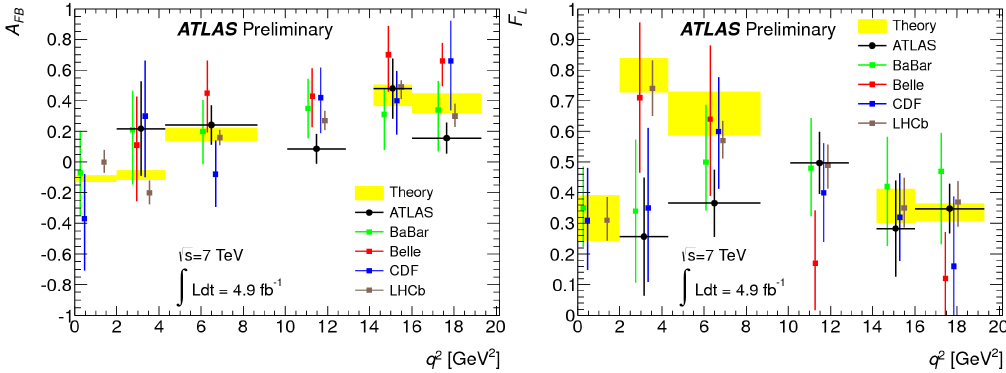
Figure 9: A FB (left) and F L (right) as a function of momentum transfer q 2 . The SM theoretical predic- tions have been calculated for the limit of small vector meson energy and for the limit of large vector meson energy. No expectation is given for the central q 2 region. The q 2 bins corresponding to J /ψ and ψ (2 S ) resonances are not